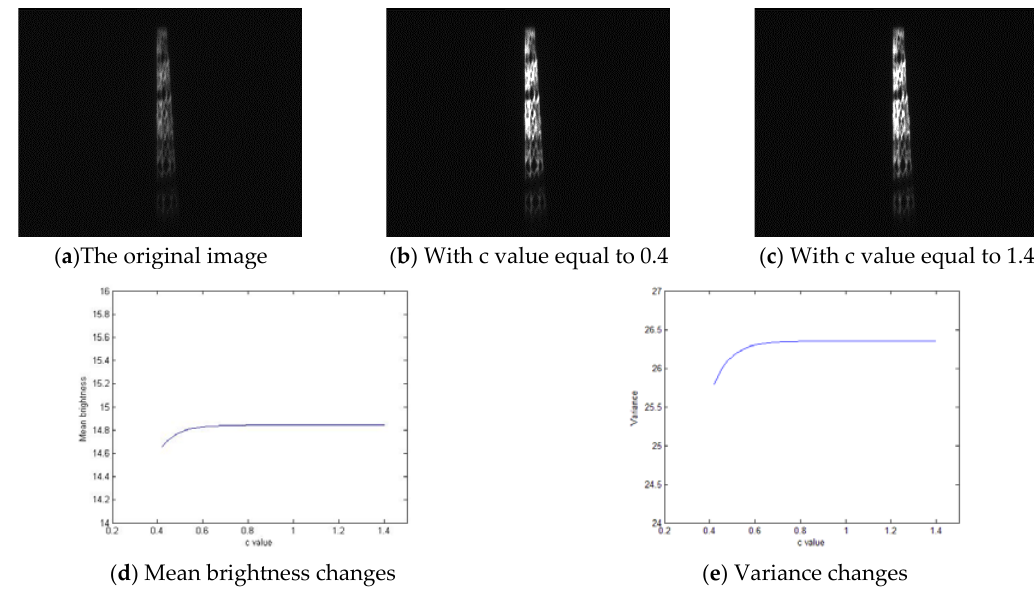
Figure 8. ( a – e ) Mean brightness and variance changes corresponding to different parameters in nighttime imaging.